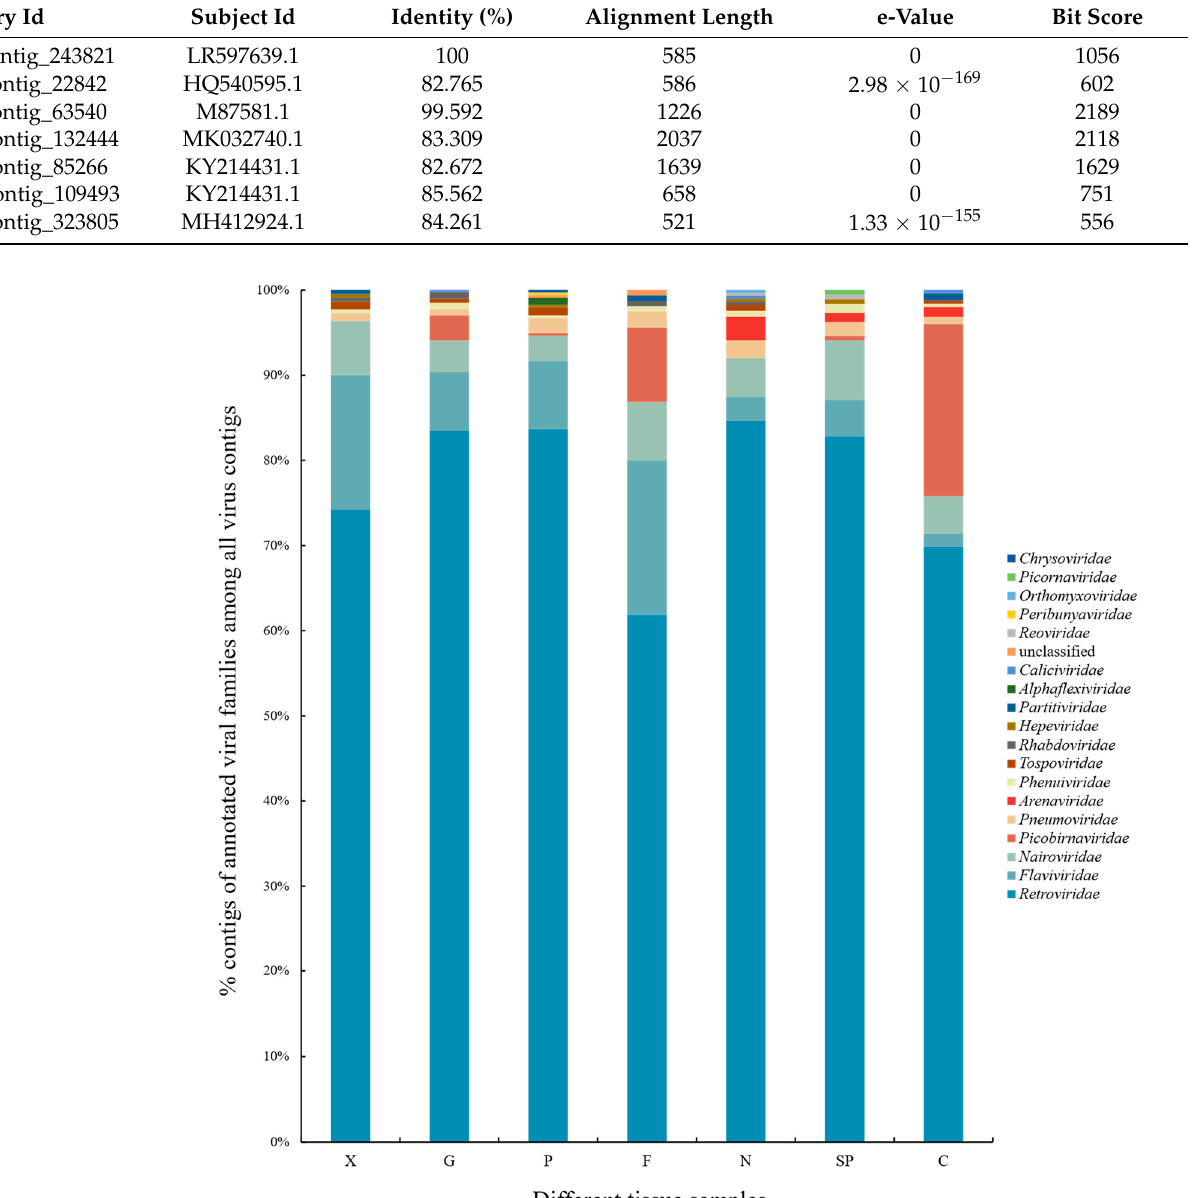
Table 2. Seven contigs that were confirmed for virus species.